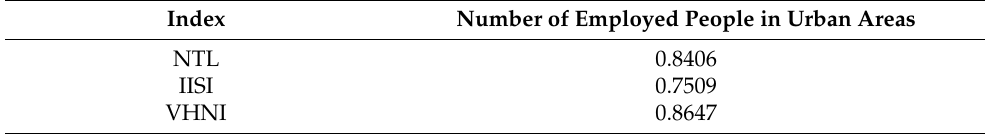
Table 4. The result of linear regression R 2 of different indices TNL on the number of urban em- ployed